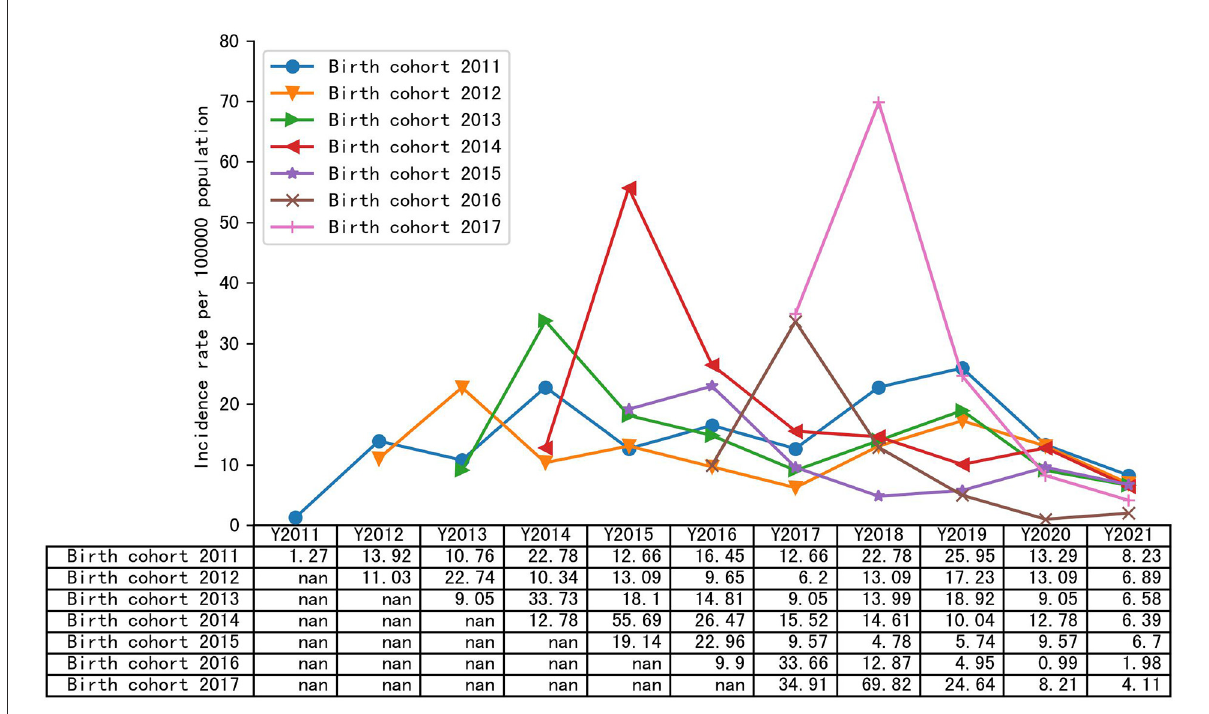
FIGURE1 Annual infection rate of different birth cohorts from 2011 to